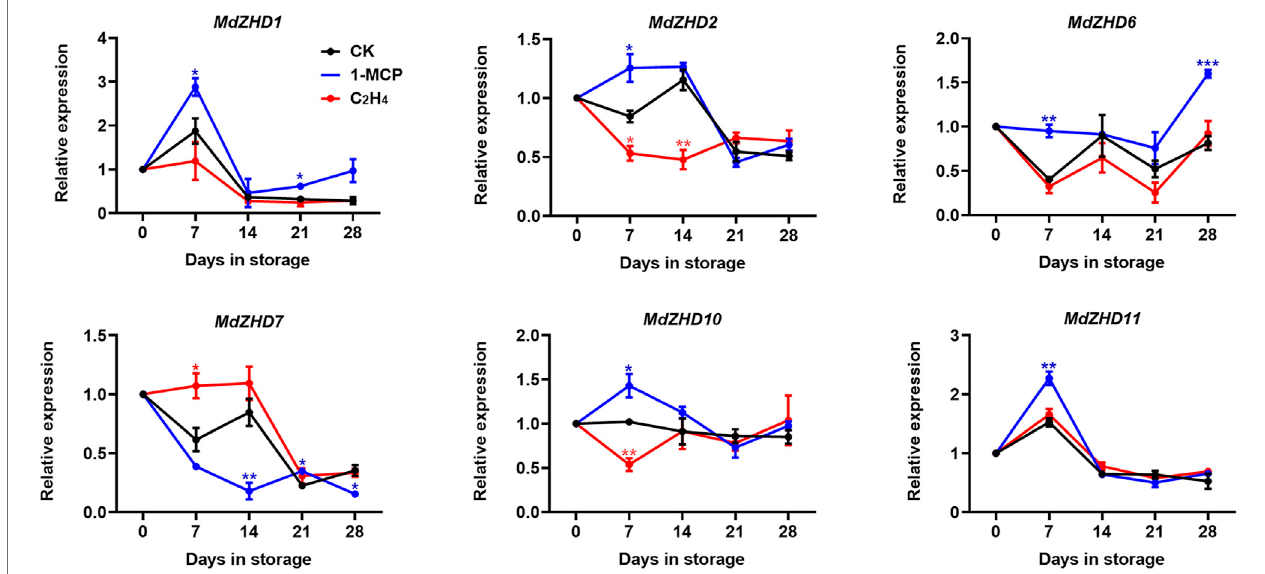
FIGURE7| Expressionpatternsof ZF-HD genesinresponsetoethyleneor1-MCPtreatmentduring “ GoldenDelicious ” applefruitripening. “ GoldenDelicious ” fruit were treated with 1-MCP (1 μ L L − 1 ), ethylene (C 2 H 4 , 100 μ L L − 1 ), and air (control/CK) for 24 h at 20 ° C. The values of day 0 fruit were set as 1. Black lines, blue lines and red lines represent the expression levels of the genes transcripts in control (CK), 1-MCP and ethylene treated fruit, respectively. Error bars represent SEs from three biological replicates (* p < 0.05; ** p < 0.01; *** p < 0.001).